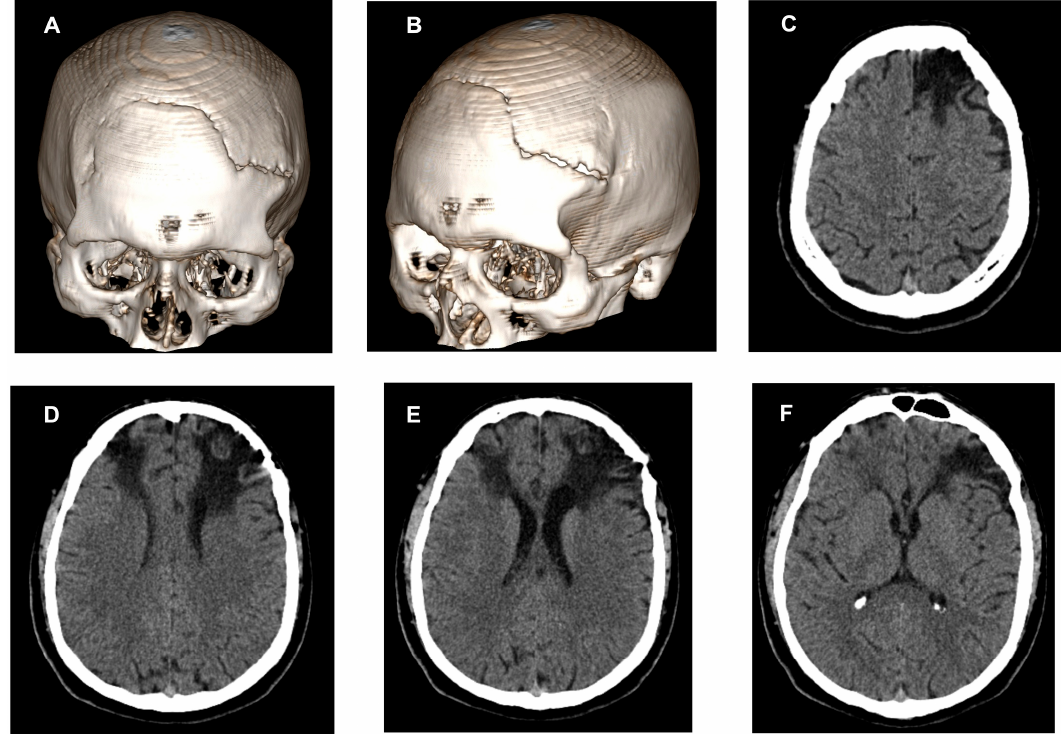
Figure 1. Computed tomography 3D bone reconstruction ( A , B ) and axial computed tomography of the brain ( C – F ). A post-traumatic bone defect of the skull can be seen in ( A – F ) shows changes of encephalomalacia in the frontal lobes’ parenchyma, affecting both white and grey matter, more extended on the left side, with enlargement of the anterior ventricular horn (aspect of acquired porencephalic lesions).